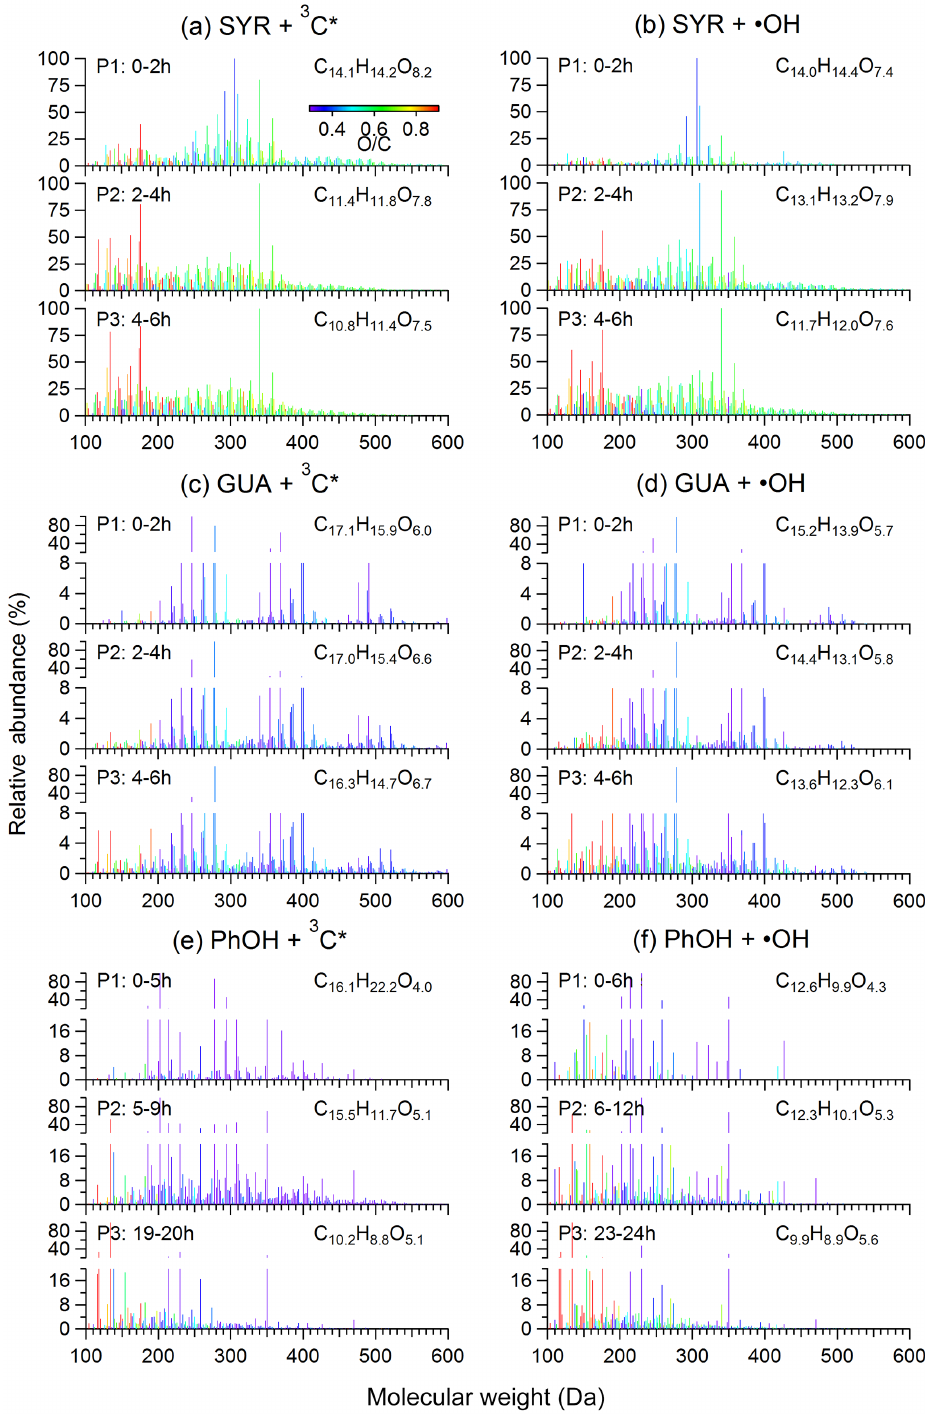
Figure 2. Negative ion mode nano-DESI mass spectra of phenolic aqSOA formed during different stages of photoreaction. Signals are colored by the O / C ratios of the molecules. The signal-weighted average molecular formula of each aqSOA is shown in the